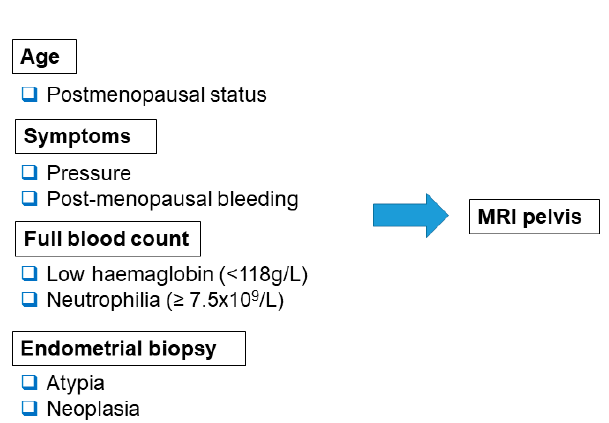
Figure 2. Pre-operative variables that should raise suspicion of LMS and prompt further imaging with MRI